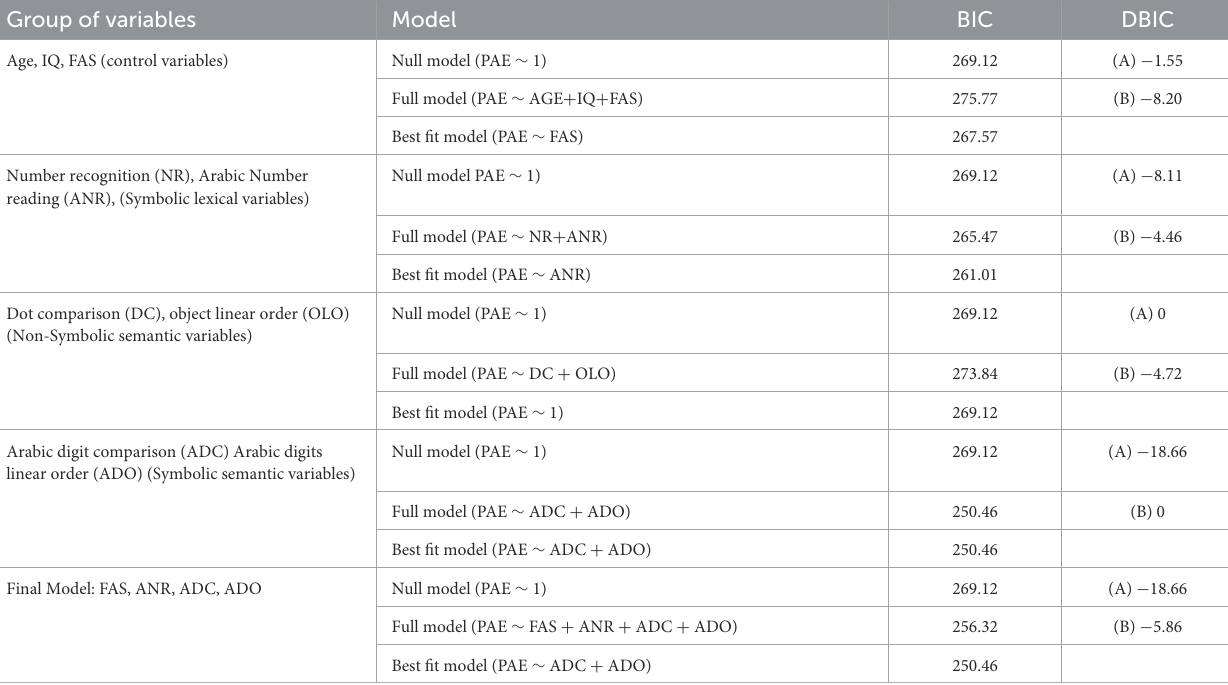
TABLE 3 Models’ selection details: null model, full model and best fit model for each group of variables and related BIC indexes and DBIC values. Group of variables